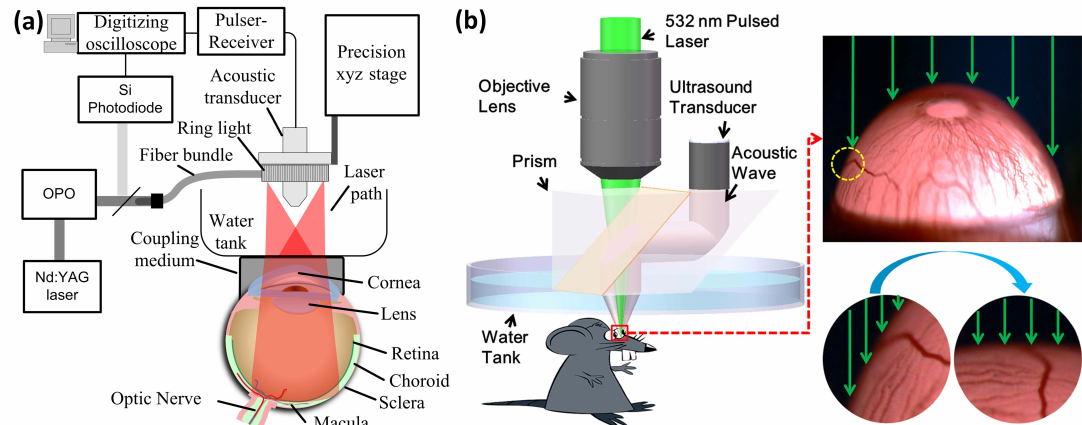
Figure 3. The PAM system used for imaging the eye in living rabbit: ( a ) schematic diagram of the acoustic resolution photoacoustic microscopy (AR-PAM). Laser excitation wavelength of 740 nm. ( b ) Diagram of the optical resolution photoacoustic microscopy (OR-PAM). Laser excitation wavelength of 532 nm. Adapted with permission from ref.